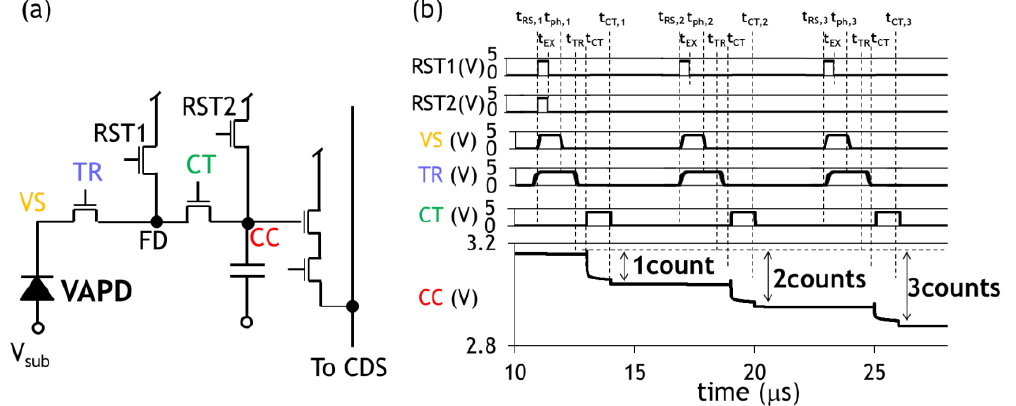
Figure 5. ( a ) A schematic diagram of a pixel circuit. ( b ) A simulated timing chart of the in-pixel that count and accumulate the charge output of VAPD effectively extracting photon signal as described in Figure 3b. The colored characters, VS, TR, CT, and CC, represent the nodes of VAPD cathode, transfer gate from VAPD to FD, charge transfer gate from VAPD to CC, and charge accumulation node, respectively.